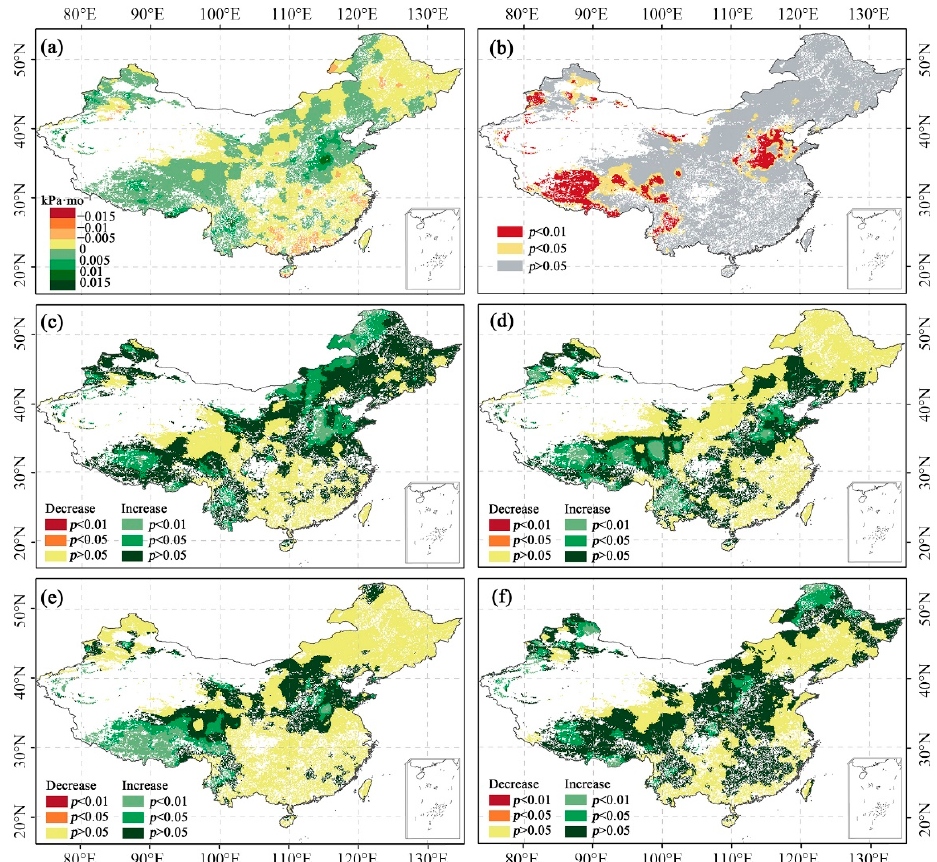
Figure 3. Spatial distribution of annual ( a ) changing trend, ( b ) p -value, and seasonal changing trend in ( c ) spring, ( d ) summer, ( e ) autumn, and ( f ) winter of vapor pressure deficit (VPD) across China from 2001 to 2020 based on the Mann–Kendall (M–K) trend test.